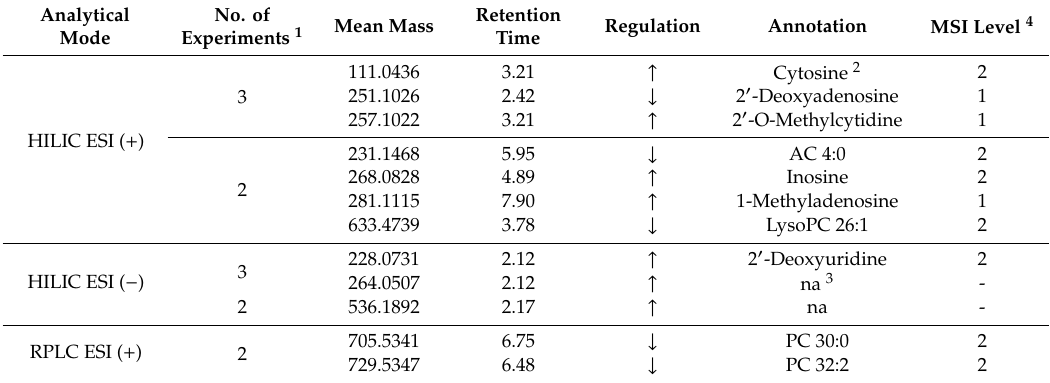
Table 2. Features significantly and relevantly altered upon 5-FU treatment of CRC